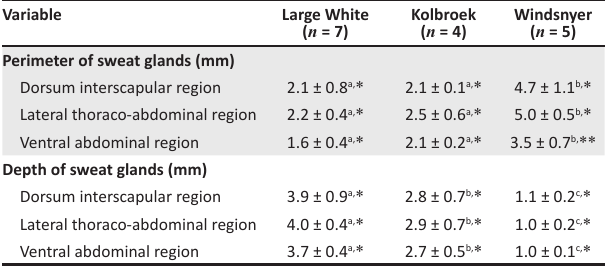
TABLE 2: A comparison of the sweat gland characteristics of the local Kolbroek and Windsnyer pigs and the exotic Large White pigs.